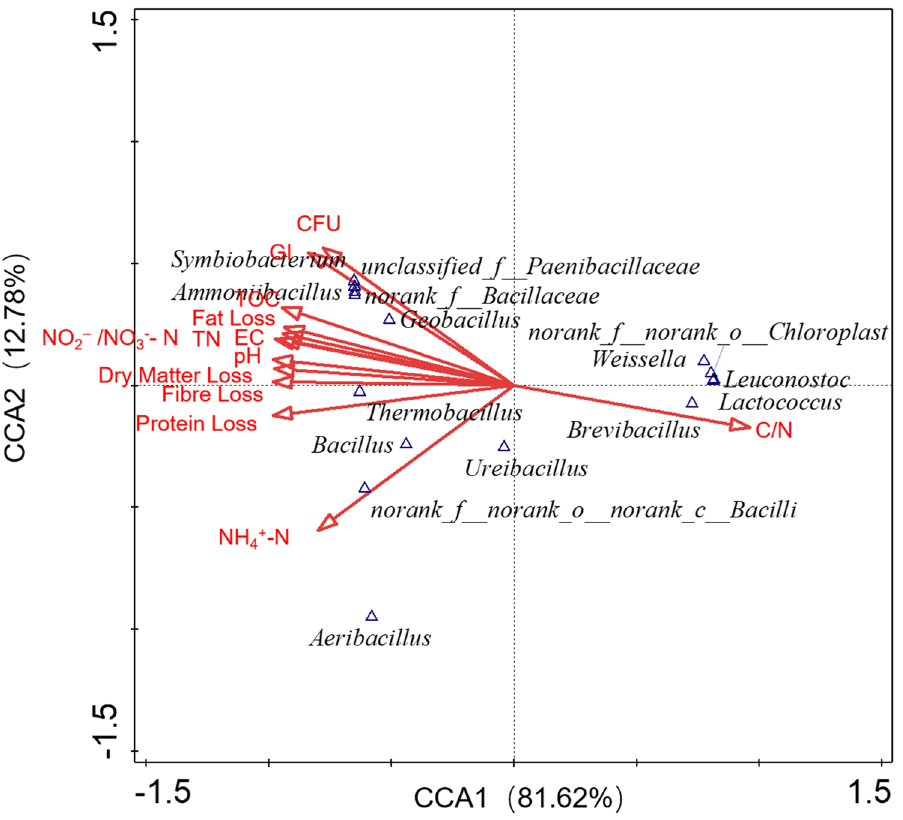
Figure 8. CCA between the composition and microbial community of CK and